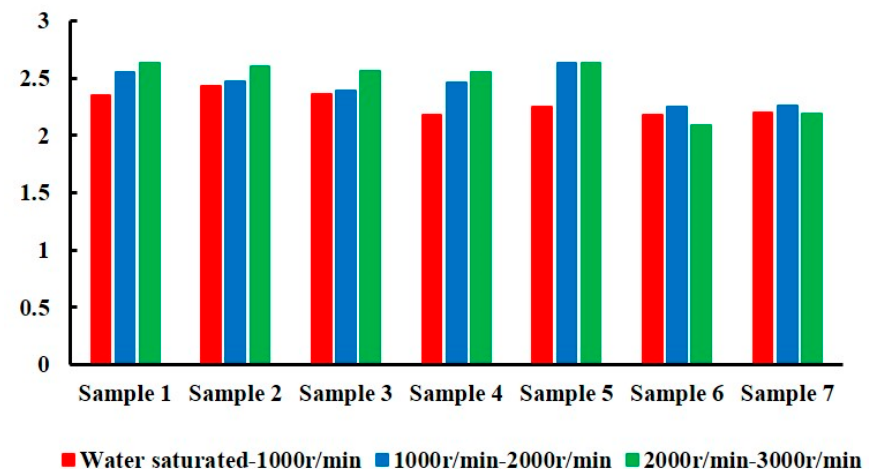
Figure 12. Plot of lg(f r ) versus Lg( T 2 ) using NMR from Sample 3. ( A ) the removed water distribution; ( B ) fractal curve of the removed water.